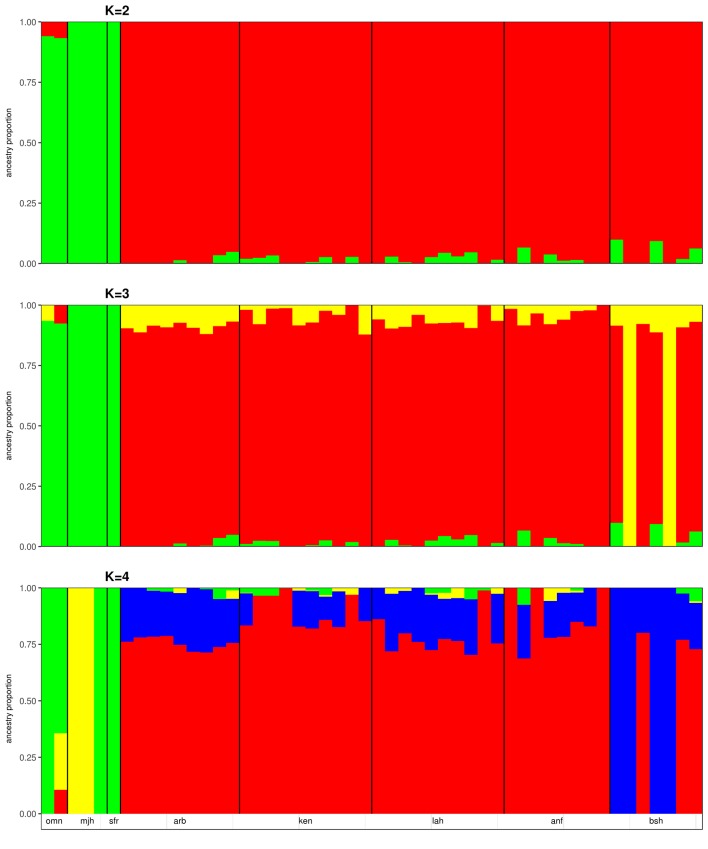
ADMIXTURE plots of Sudanese and Arabian Peninsula camels for cluster values (K) from 2 to 4. omn, Omani; mjh, Majaheem; sfr, Sofor; arb, Arabi; ken, Kenani; lah, Lahawi; anf, Anafi; bsh, Bishari.